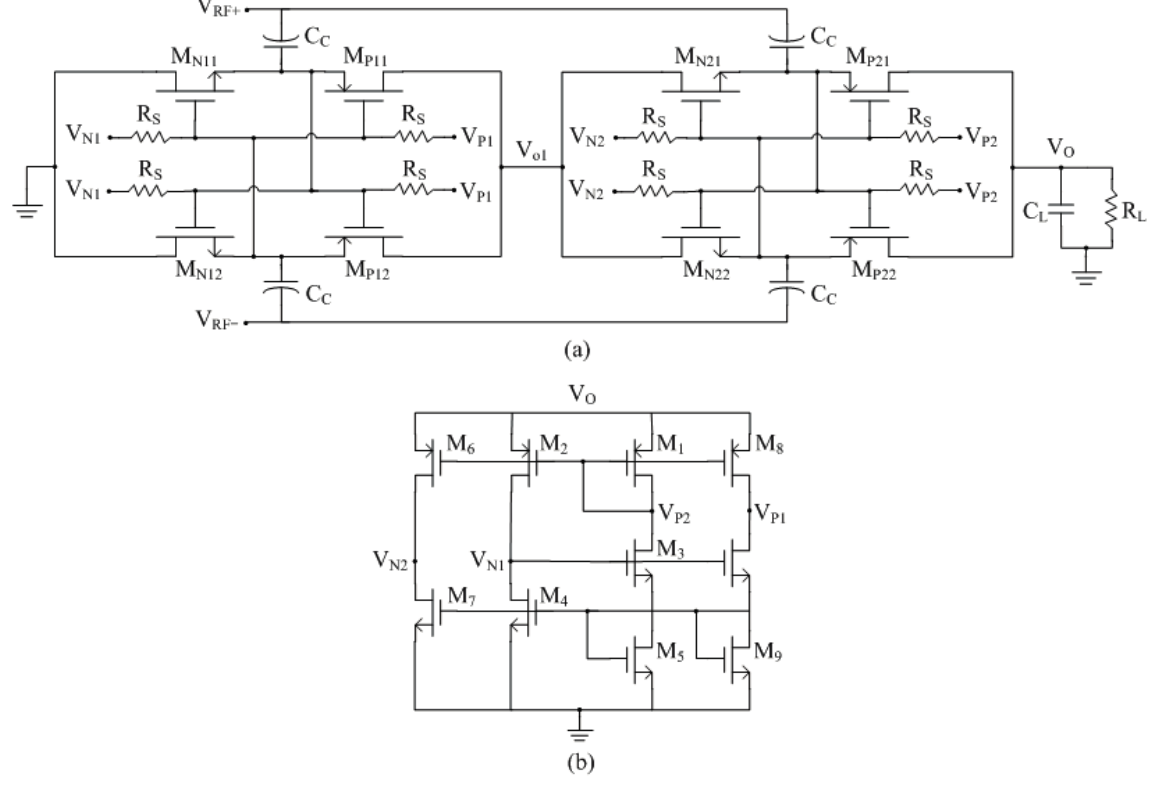
Figure 4. Schematic of the proposed rectifier: ( a ) two-stage rectifier and ( b ) bias-voltage